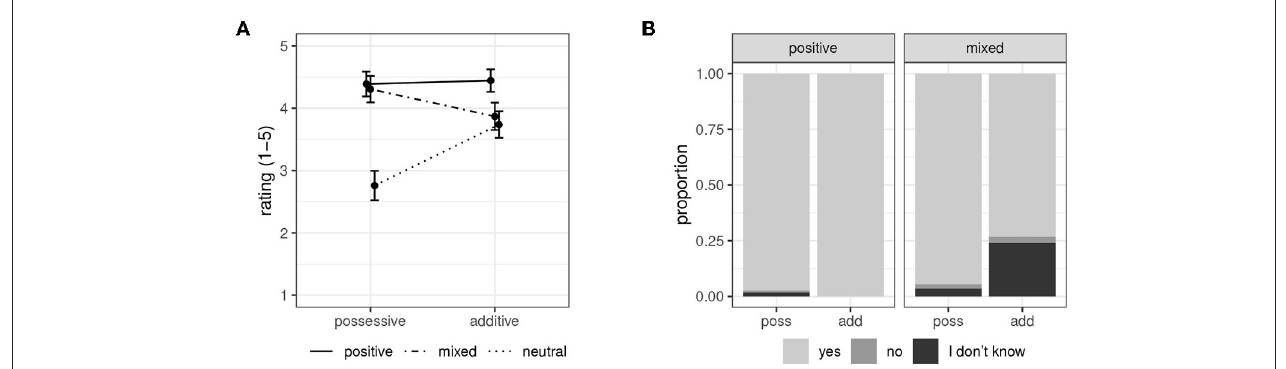
FIGURE 3 | Results of experiment 1: felicity ratings with 95% confidence intervals (A) and answer proportions (B) .